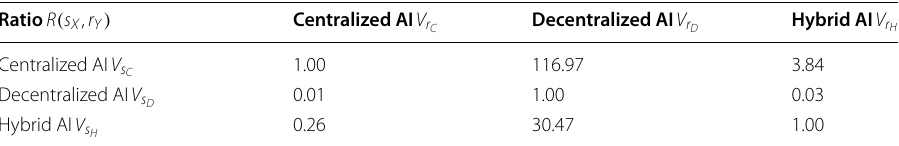
Table 8 Comparison ratio based on the average age reduction and the associated cost of the three learning